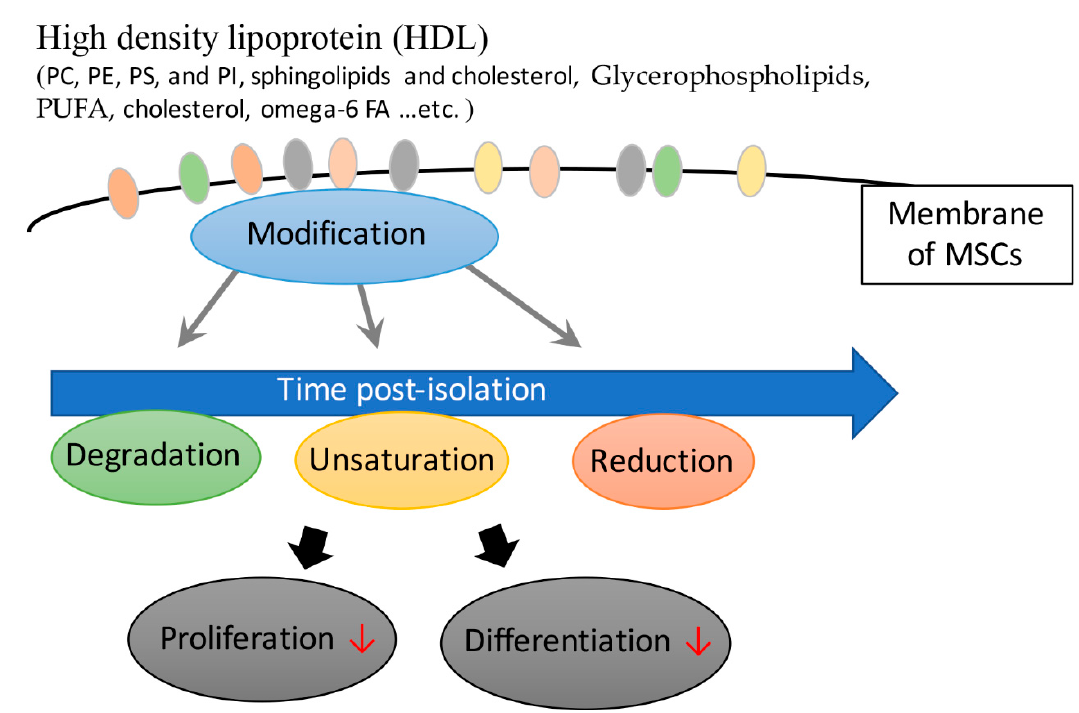
Figure 3. The positive regulatory role of high-density lipoprotein (HDL) in maintaining MSC function Figure 3 The positive regulatory role of high ‐ density lipoprotein (HDL) in maintaining MSC and di ff function and differentiation.